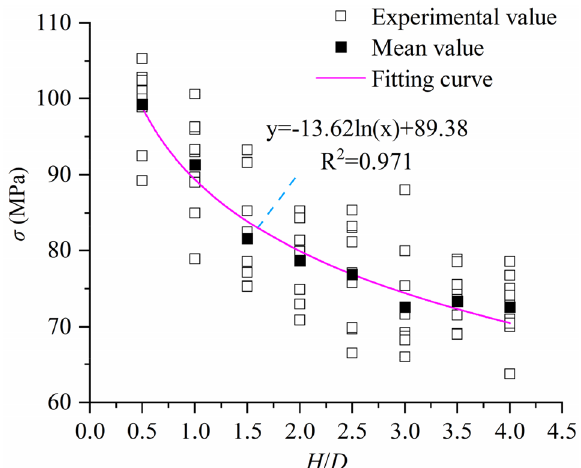
Figure 15. Size effect curve of uniaxial compressive strength of defect